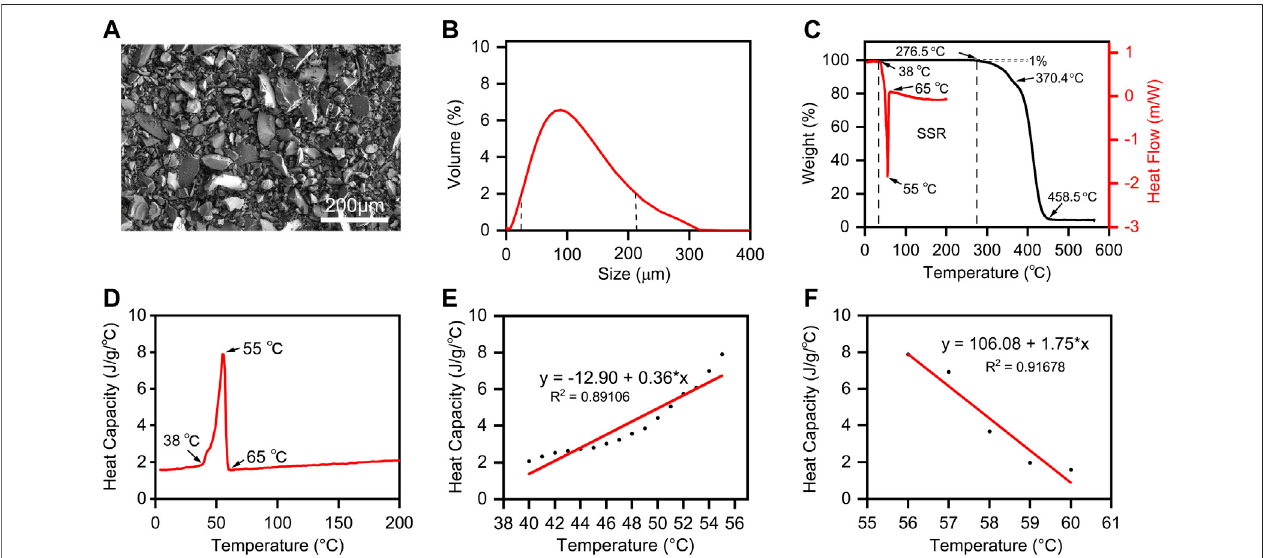
FIGURE 3 | The Properties of PCL powder. (A) SEM image and (B) size distribution of PCL powders; (C) DSC and TGA analysis of PCL powder. The endo- and exothermal heat fl ow of PCL powders was characterized by heating and cooling from 0 ° C to 200 ° C at the rate of 10 ° C/min. The weight ratio of PCL decomposition started from 0 ° C to 600 ° C at the rate of 10 ° C/min. The stable sintering region (SSR) is indicated from the onset of melting to the onset (1%) of decomposition. (D) Plot of the temperature-dependent speci fi c heat capacity of PCL powders from 0 ° C to 200 ° C. (E) Linear fi tting of heat capacity with temperature from melting initiation to the melting point. (F) Linear fi tting of heat capacity with temperature from the melting point to the recrystallization